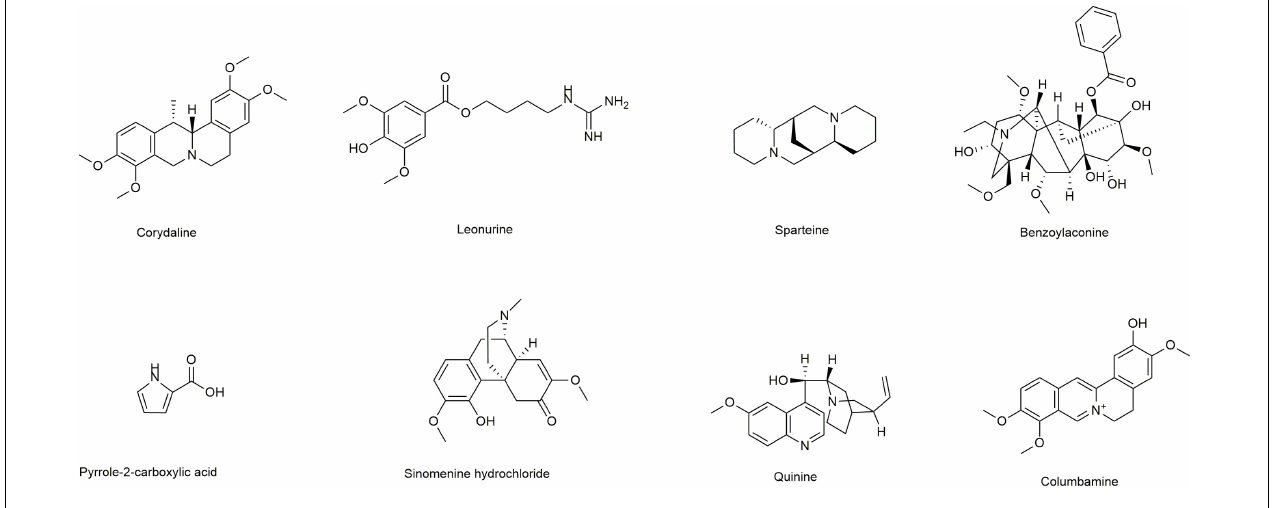
FIGURE 1 | Chemical structures of different